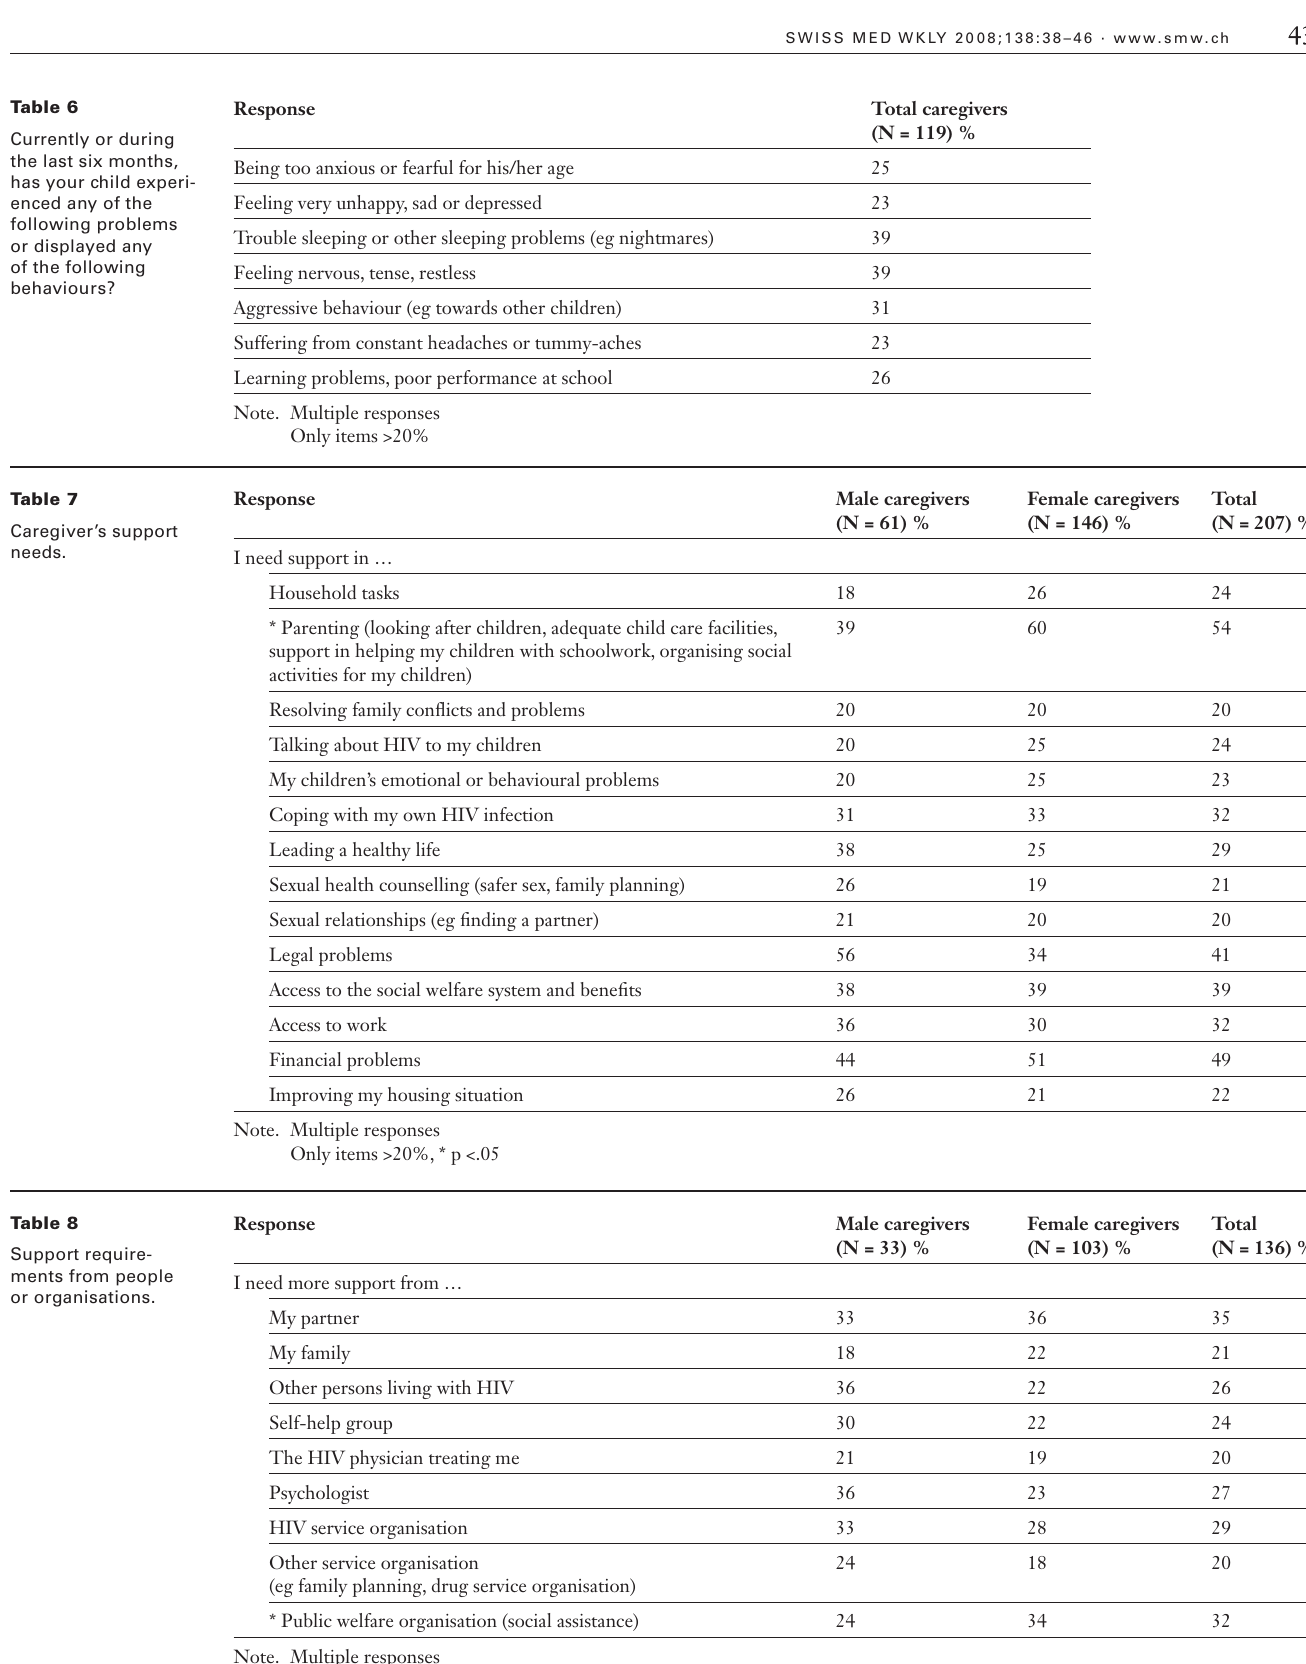
Currently or during the last six months, has your child experi- enced any of the following problems or displayed any of the following behaviours?